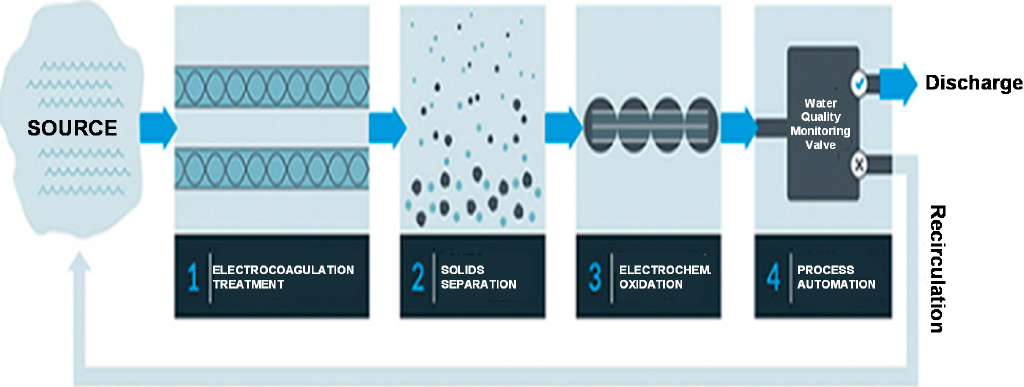
Figure 7. Simplified schematic representation of the EC/EO combined process for SCWG brine treatment.